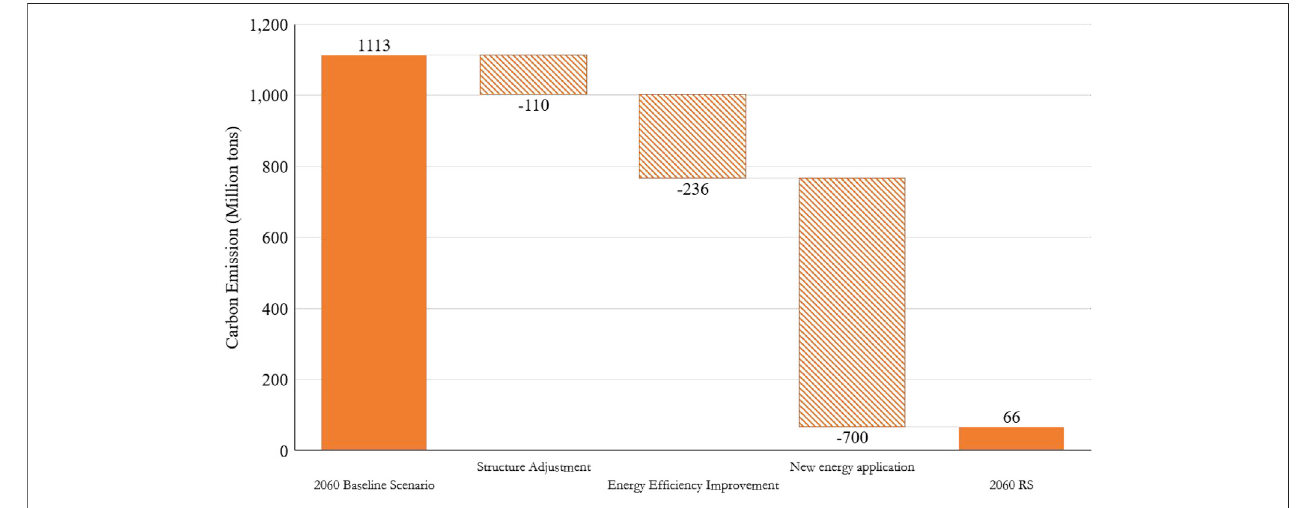
FIGURE 14 | Deconstruction of carbon emissions under the Radical scenario in 2060.